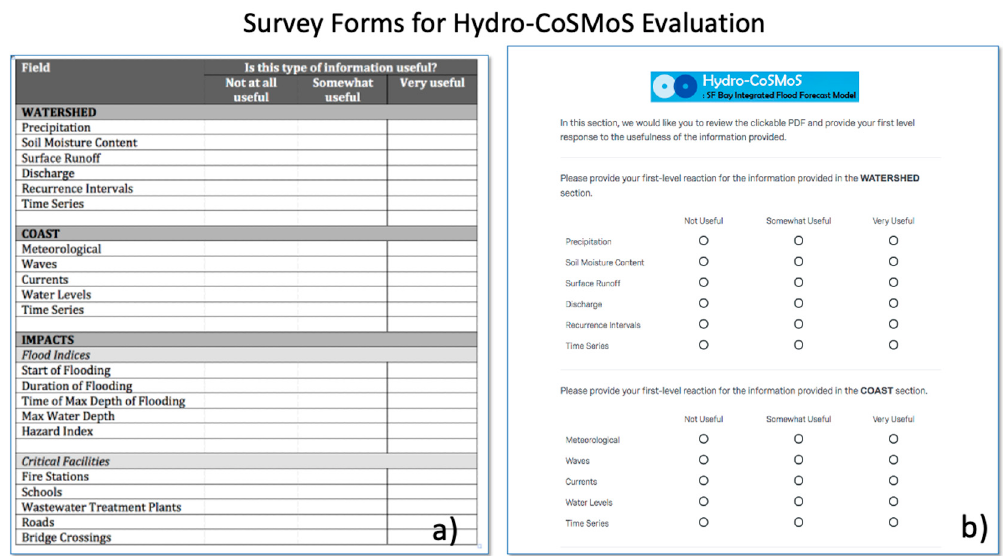
Figure 12. User survey forms for the TTE. ( a ) Participants in the room were provided a hard copy printout in which they could indicate the usefulness of the model product. ( b ) Participants on the phone were provided a link to an online survey in which they could also provide real-time feedback.